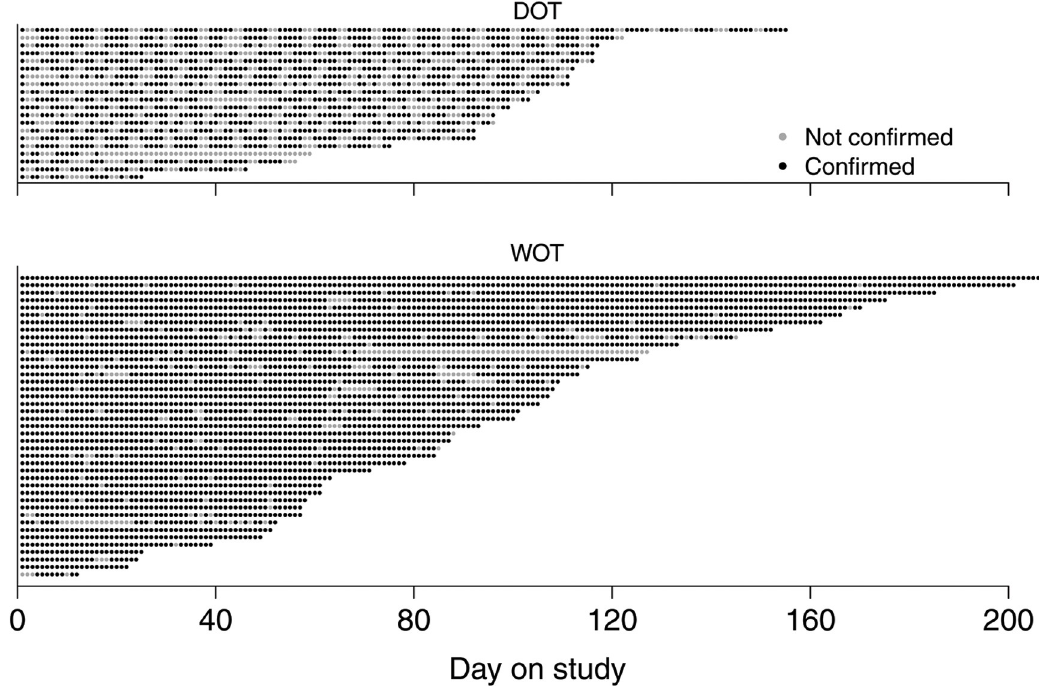
Fig 2. Visualization of confirmed versus unconfirmed doses. Each row represents one patient. Each dot represents one day. Confirmed (black) and not confirmed (gray) doses are shown for each patient on study through the course of the follow-up based on the ITT analysis. Patients are ordered according to their length of follow-up after randomization. DOT, directly observed therapy; ITT, intent to treat; WOT, wirelessly observed therapy.